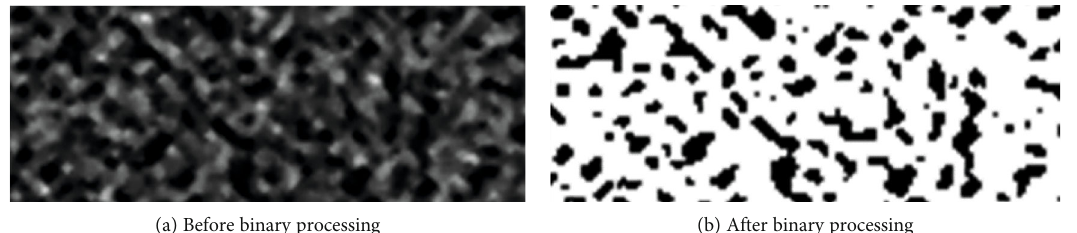
Figure 5: Sandstone images before and after binary processing.